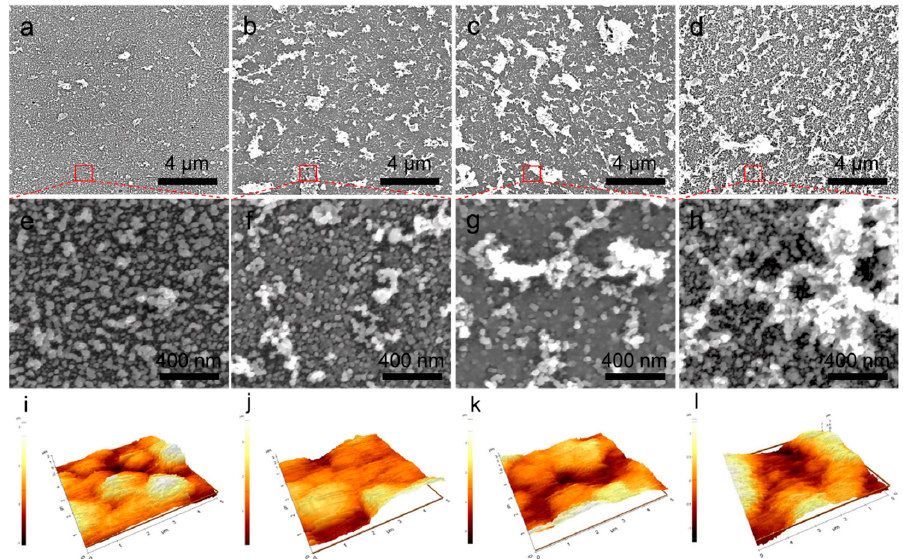
Figure 3. Characterization of the AgNPs-rGO composites fabricated at the different amplitudes of DC electric fields during the laser reduction. ( a – d ) SEM images of the AgNPs-rGO1-E1, the AgNPs-rGO1- E2, the AgNPs-rGO1-E3 and the AgNPs-rGO1-E4 substrates applied with 7.5 V, 15 V, 22.5 V and 30 V, respectively; ( e – h ) The high magnification SEM images; ( i – l ) AFM results of each of